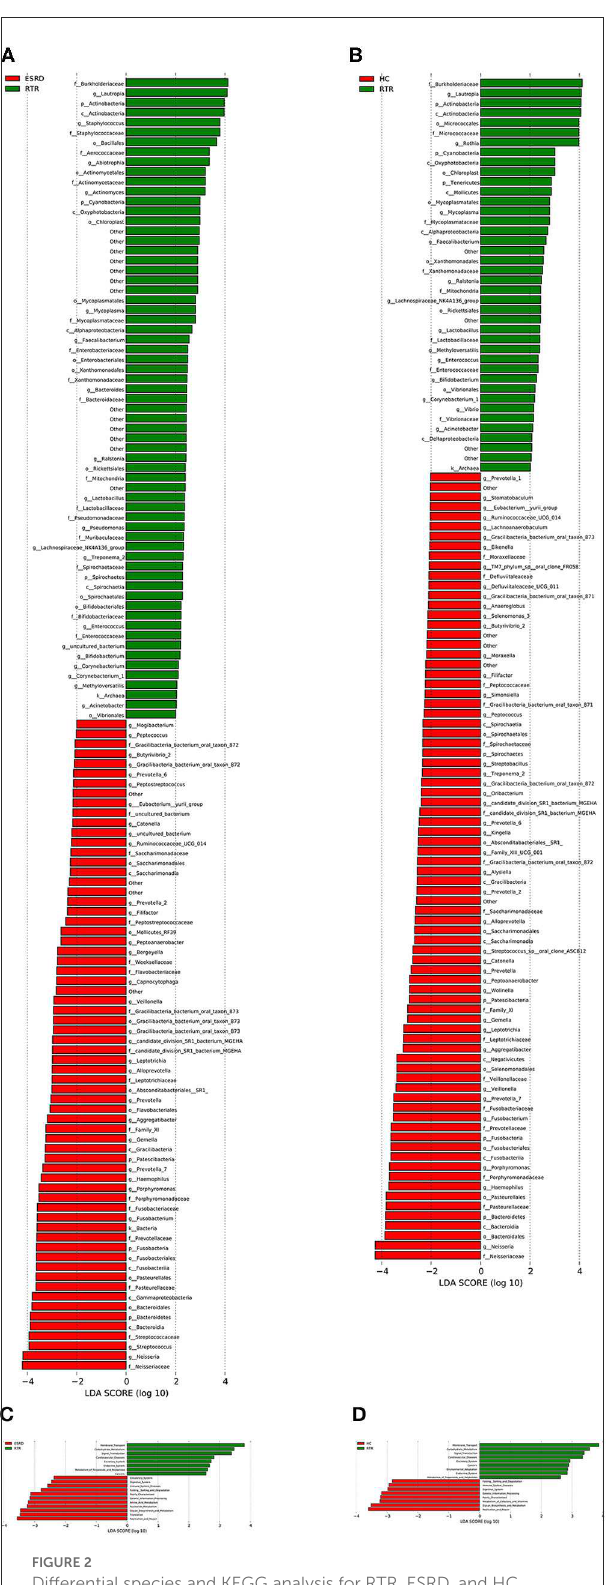
FIGURE2 Differential species and KEGG analysis for RTR, ESRD, and HC groups: (A) LEfSe analysis of the salivary microbiota composition between RTR and ESRD groups; (B) LEfSe analysis of the salivary microbiota composition between RTR and HC groups; (C) LEfSe analysis of the predicted function between RTR and ESRD groups; (D) LEfSe analysis of the predicted function between RTR and HC